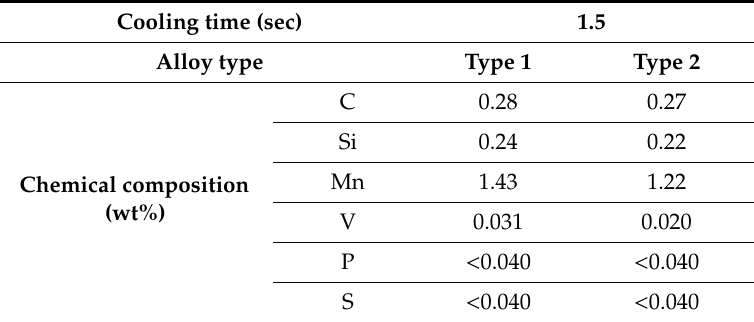
Table 4. Performance test with respect to alloy type.